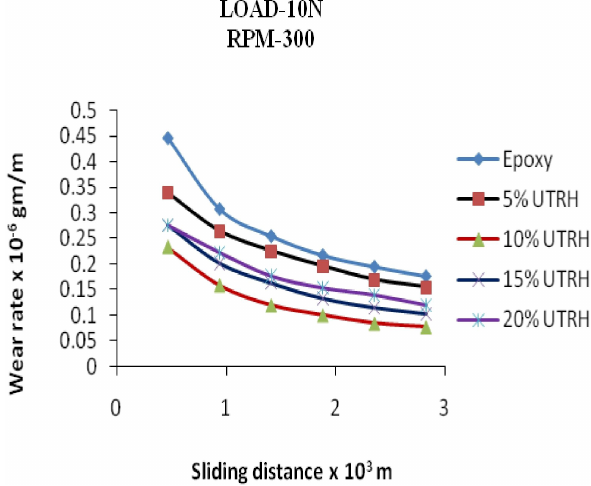
Figure 11: Variation of wear rate with RH content for a fixed load